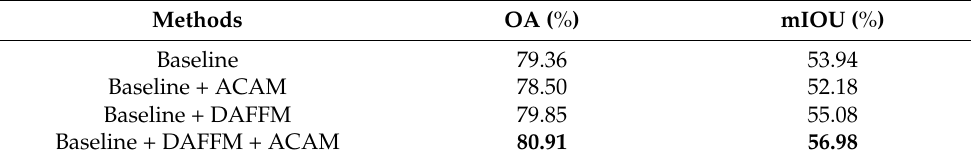
Table 2. Evaluation of land cover classification accuracy on GaoFen-2 dataset